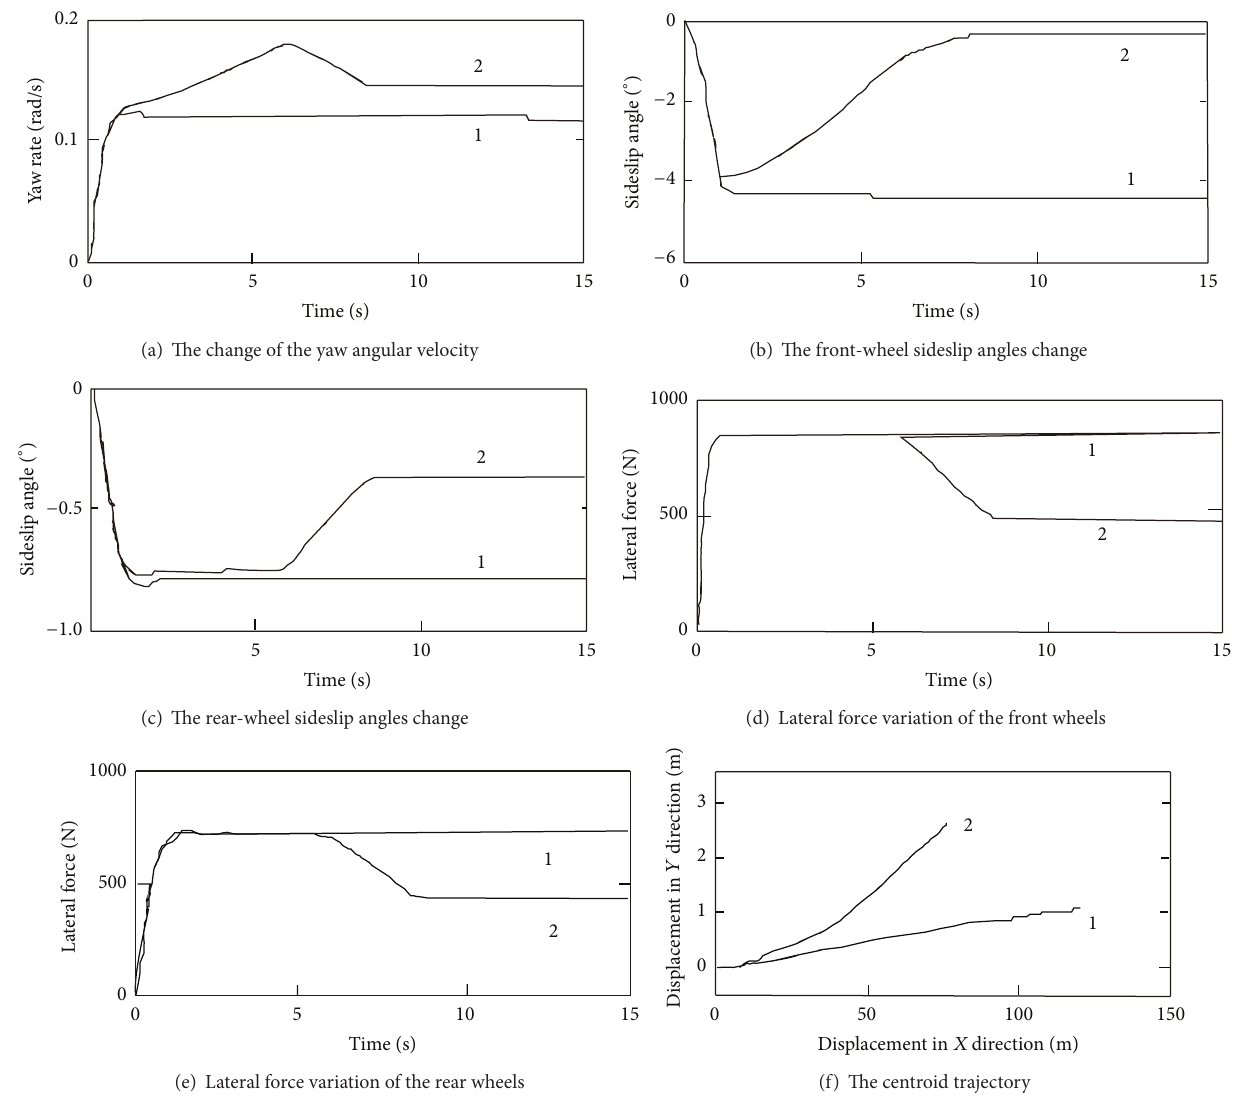
Figure 5: The characteristics of cars excessive sideslip on the low friction road and then slowing down. Curve 1: the speed is 28.8 km/h; Curve 2: the initial velocity is 28.8 km/h and then is decreased to 14.4